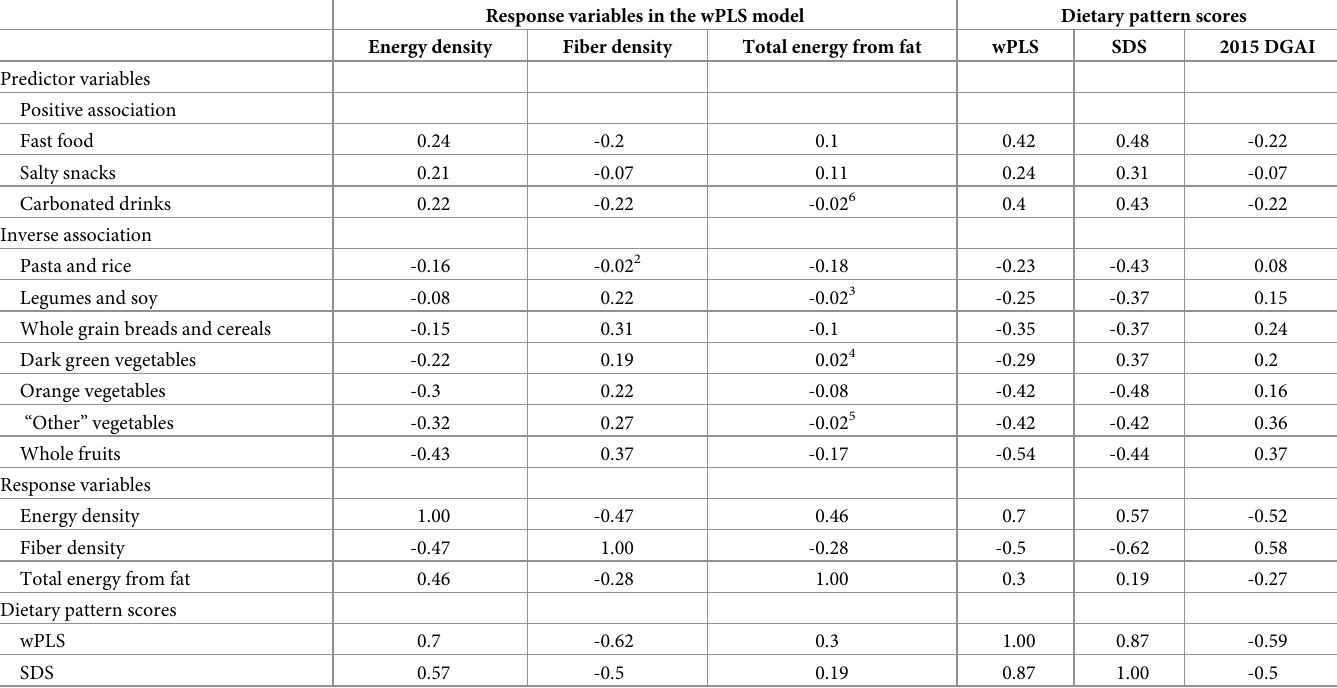
Table 2. Pearson correlation coefficients between food predictors 1 which loaded significantly in the wPLS model (i.e. loading factor � |0.17|); response variables in the energy-dense, high-fat and low-fiber density (“obesogenic”) dietary pattern generated from the wPLS model; the simplified dietary pattern score (SDS);